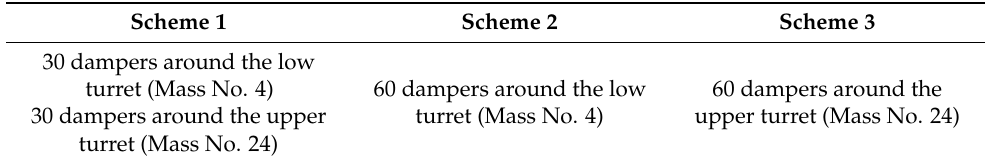
Table 3. Damper installation schemes.